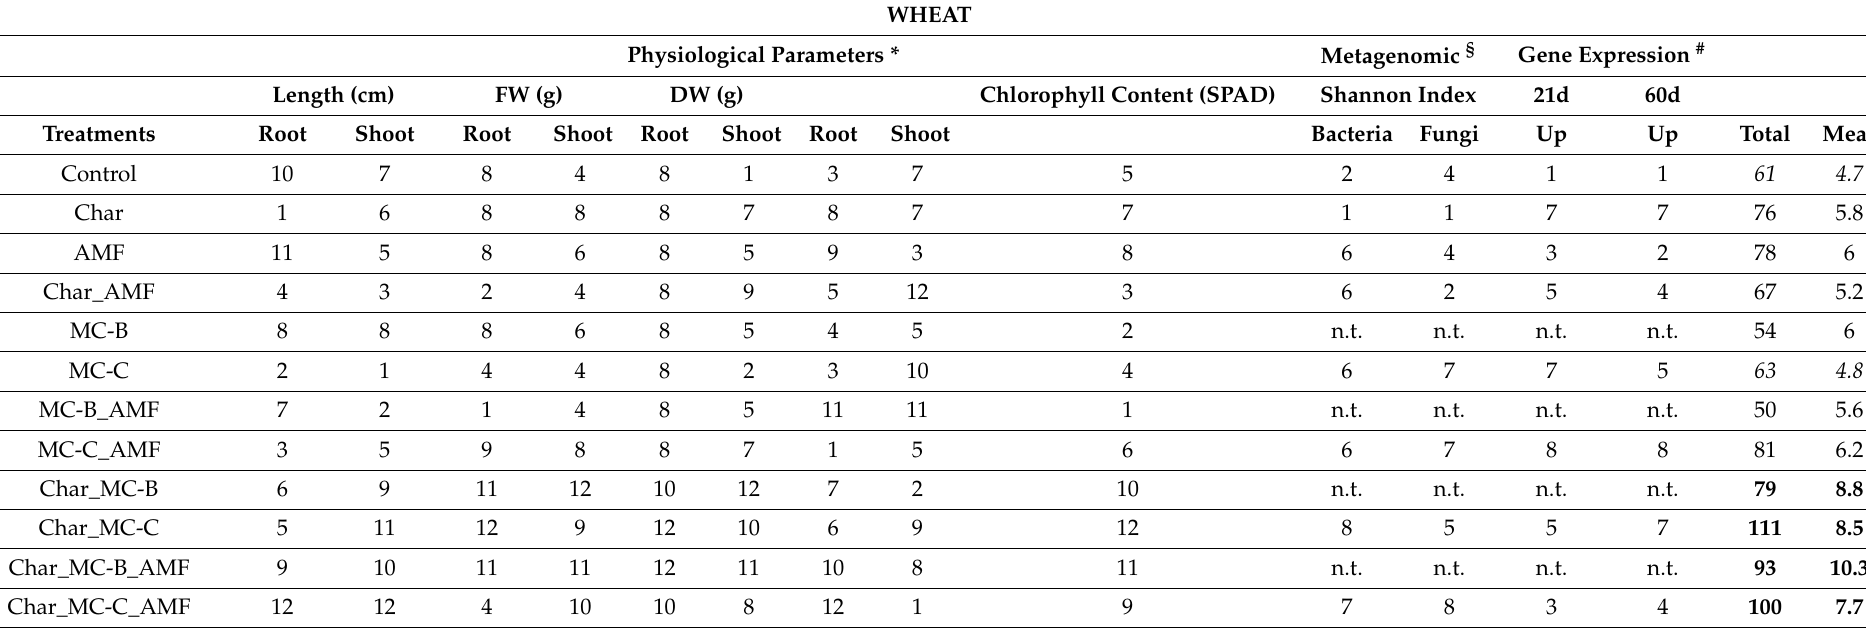
Table 3. Ranking the effectiveness of treatments in wheat and maize with a combination of physiological, metagenomic, and gene expression data. For each plant and treatment condition, the average values of the different parameters have been ranked and scores have been assigned $ . The scores have been summed over all parameters (column “Total”) and averaged (column “Mean”) to allow comparison of conditions with an unequal number of parameters. Bold indicates the treatment(s) with the highest ranking and italics indicate the treatment(s) with the lowest